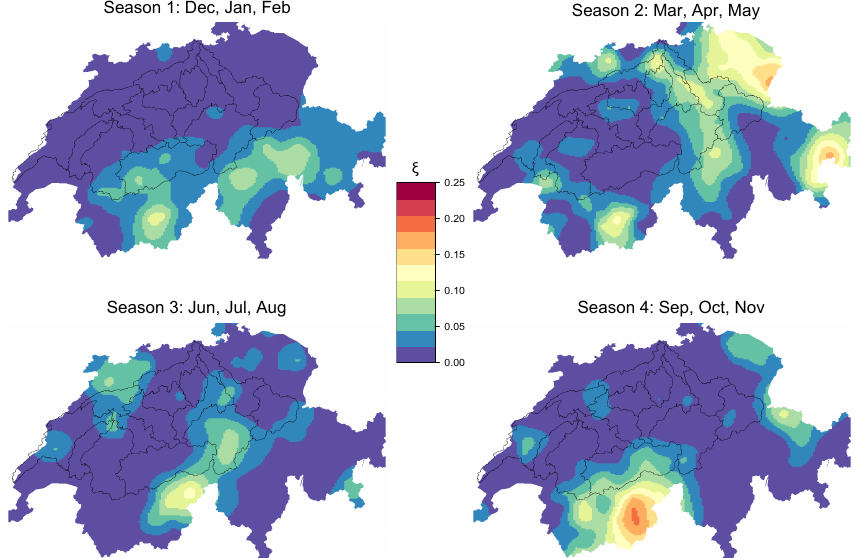
Figure 5. Regionalized ξ parameters at a 3-day scale, for the different seasons. Here, we present the spatial interpolation of at-site estimates for a better readability of their